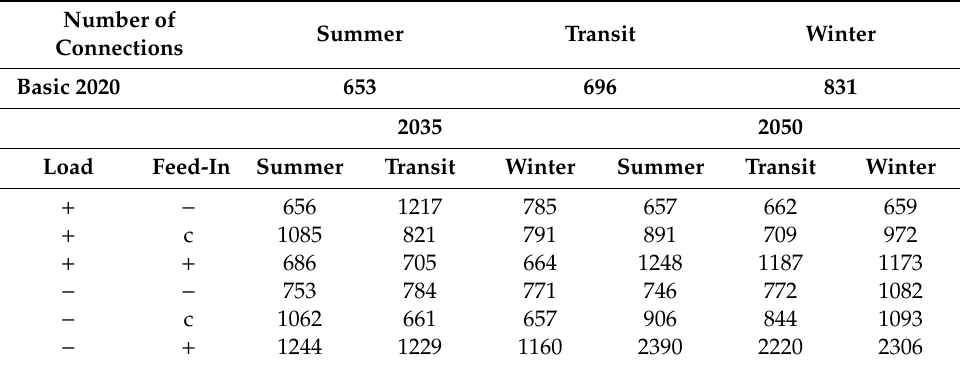
Table 9. Number of interconnections for di ff erent scenarios.